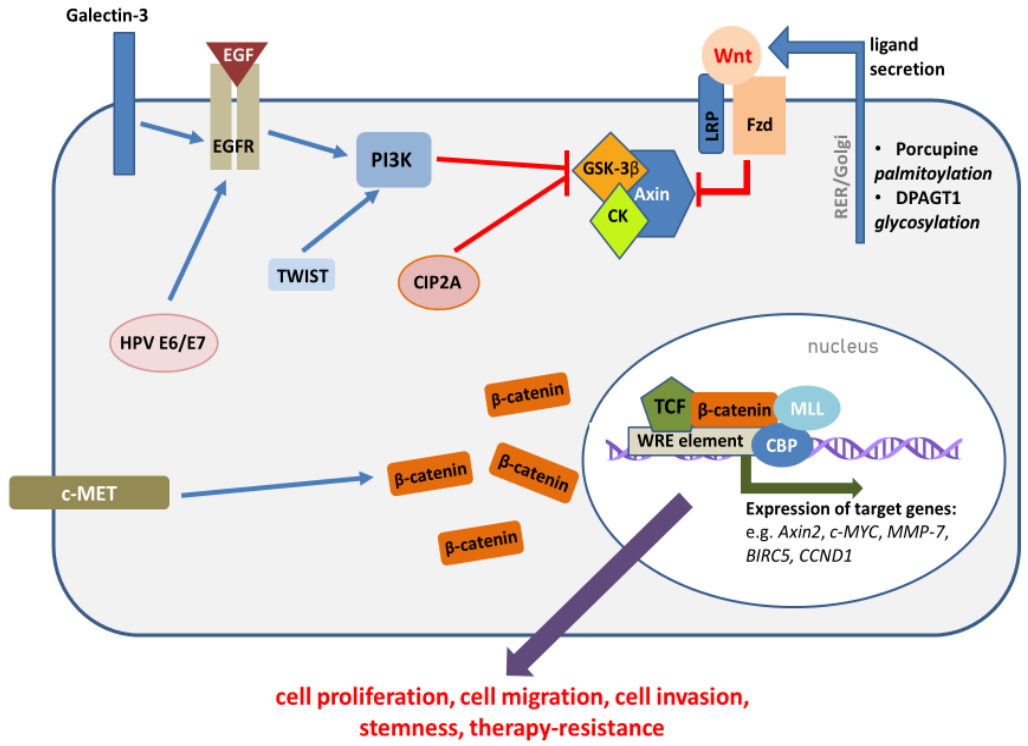
Figure 2. The activation of the canonical Wnt pathway in head and neck cancers is mediated by various factors. The synthesis of Wnt ligands is enhanced, which is related to the elevated activity of enzymes responsible for post-translational modifications—glycosylation and palmitoylation. The increased activity of Wnt ligands results from the reduced expression of extracellular Wnt antagonists. After secretion, Wnt ligands activate FZD / LRP receptors, which destabilizes the destruction complex, which can no longer phosphorylate β -catenin and stimulate its degradation. The destabilization of the destruction complex may also be mediated by the activation / overexpression of other molecular factors (e.g., EGFR, PI3K, c-MET, CIP2A), including HPV infection (details provided in the text). The resulting translocation of β -catenin to the nucleus activates TCF / LEF-mediated transcription of WRE-regulated genes, which relies on the cooperation with histone modifying proteins (MLL,